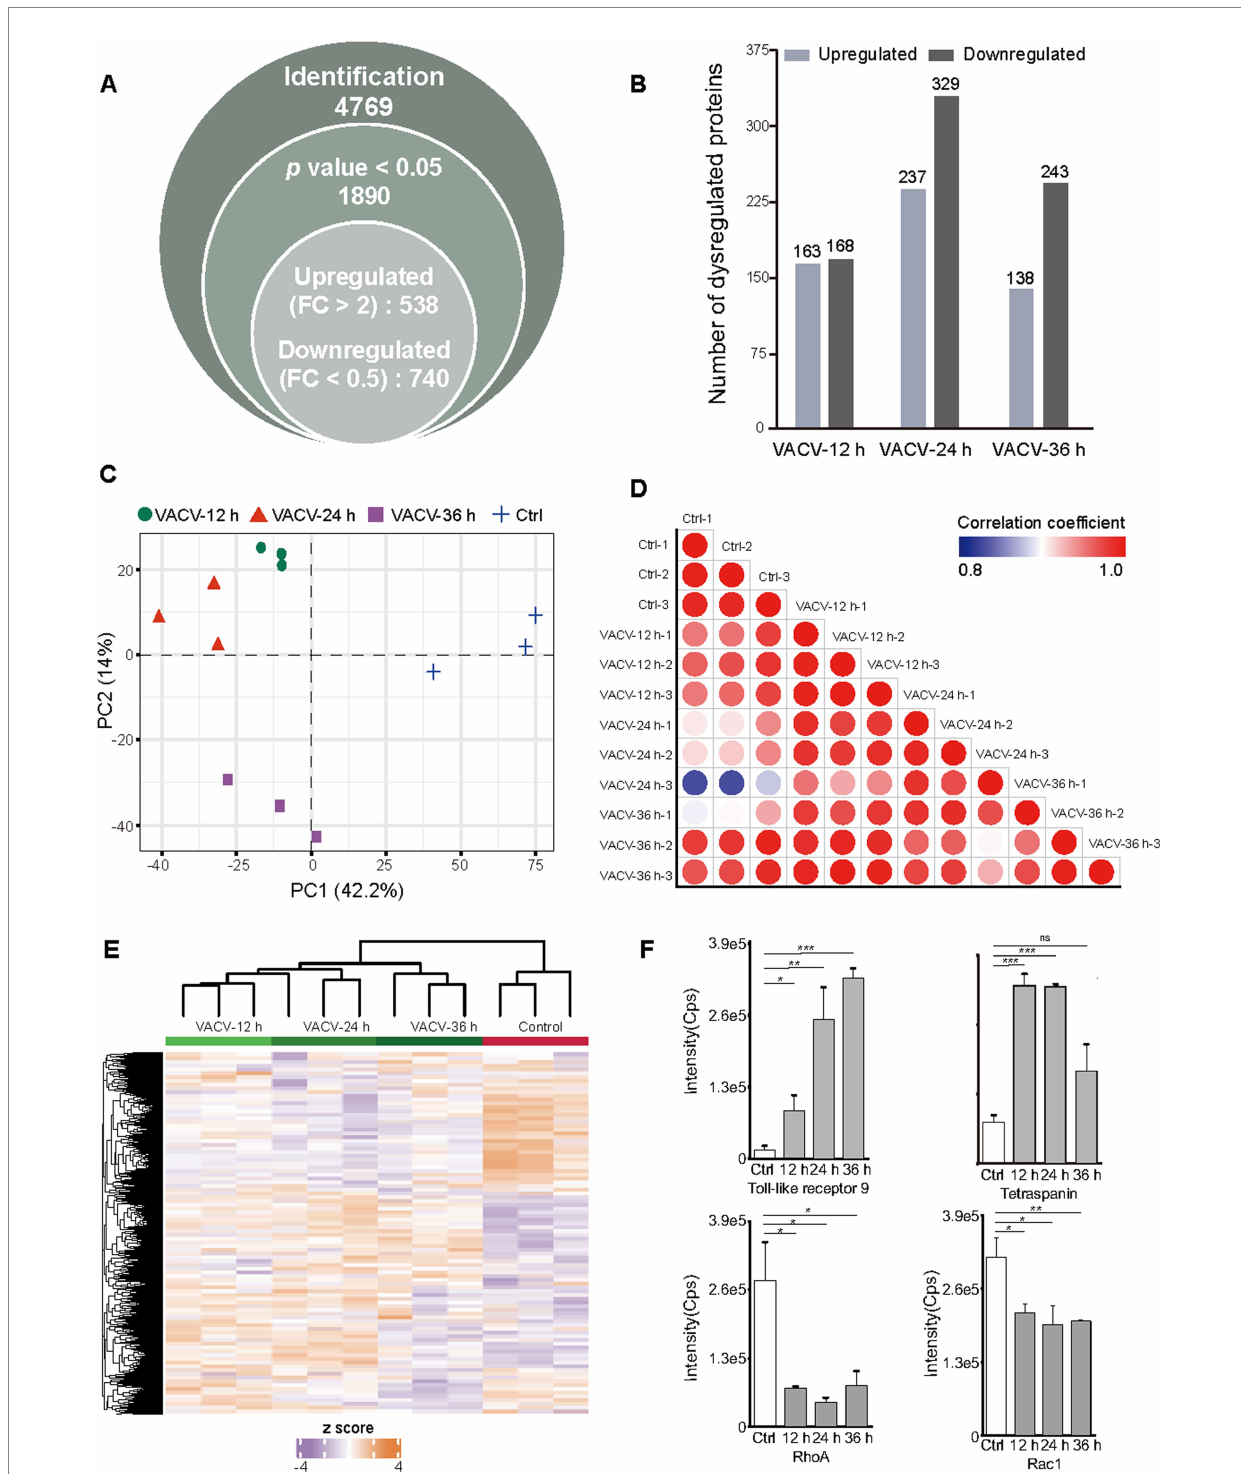
FIGURE 3 Temporal proteomic qualitative and quantitative analysis of VACV-induced cell migration. (A) The number of identified protein groups, significantly expressed proteins under the threshold of p value <0.05, and upregulated and downregulated proteins under the threshold of fold change >2. (B) The number of quantitatively upregulated and downregulated proteins at different time points of infection (12, 24, and 36 h.p.i.) under the thresholds of value of p < 0.05 and fold change > 2, respectively. (C) The principal component analysis (PCA) plot based on temporal proteomics of non-infected cells and VACV-infected cells at different time points of infection. (D) The sample correlation plot of non-infected and VACV-infected Vero cells. The color shade represents coefficients between these groups. Each group has three biological replicates. (E) The heatmap of dysregulated proteins under the criteria of p value < 0.05 and fold change > 2 of non-infected and VACV-infected Vero cells. Each group has three biological replicates. (F) The intensities of immune-associated proteins, including toll-like receptor 9 and tetraspanin, and actin cytoskeleton regulation-associated proteins, including RhoA and Rac1. Data are mean ± SEM. * p < 0.05, ** p < 0.01, and *** p < 0.001 (unpaired t -test); ns, not statistically